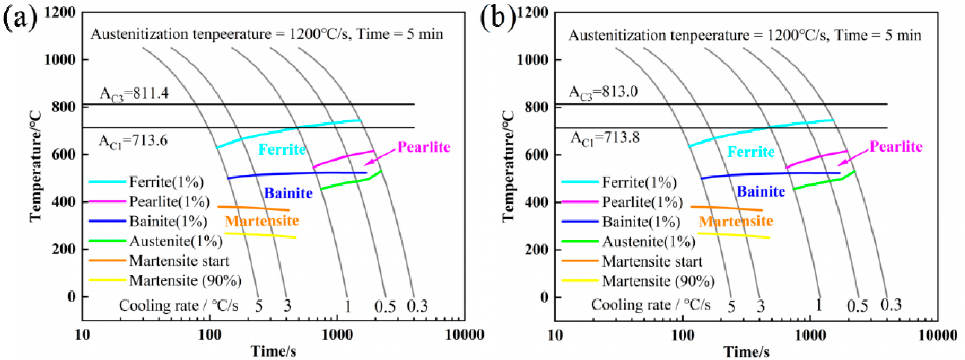
Figure 5. CCT diagram calculated using the JMatPro software: ( a ) steel 1#, and ( b ) steel